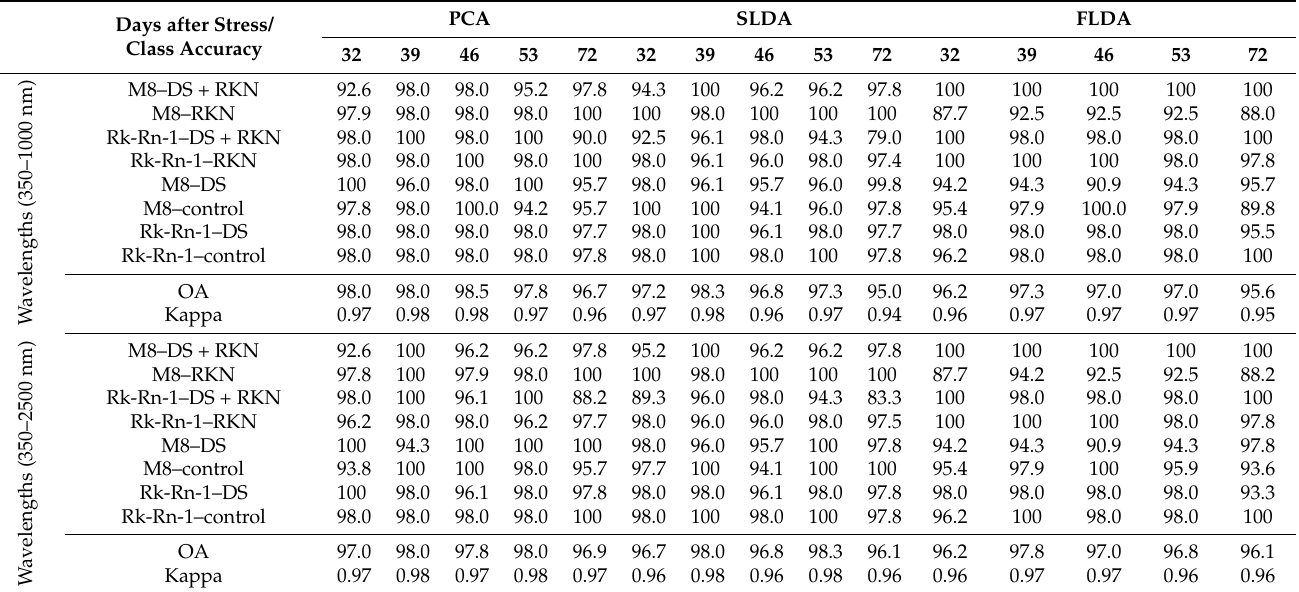
Table 3. Classification accuracies on an eight-class problem (control vs. drought stress vs. RKN stress vs. genotypes) using leaf spectral reflectance information between 350–1000 nm and 350–2500 nm of two cotton genotypes (M8 and Rk-Rn-1) measured at 32, 39, 46, 53, and 72 days after stress treatment in